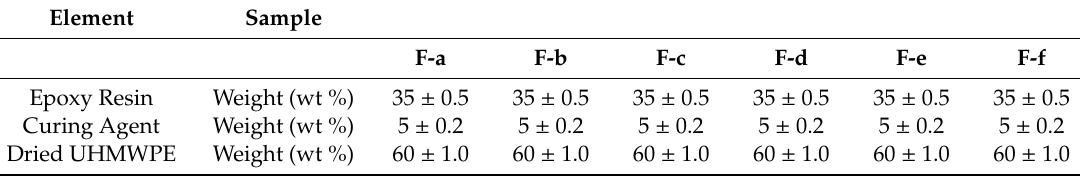
Figure 2. Preparation of the UHMWPE / epoxy composite. Table 3. Mass fraction of epoxy, curing agent, the fiber in UHMWPE / epoxy